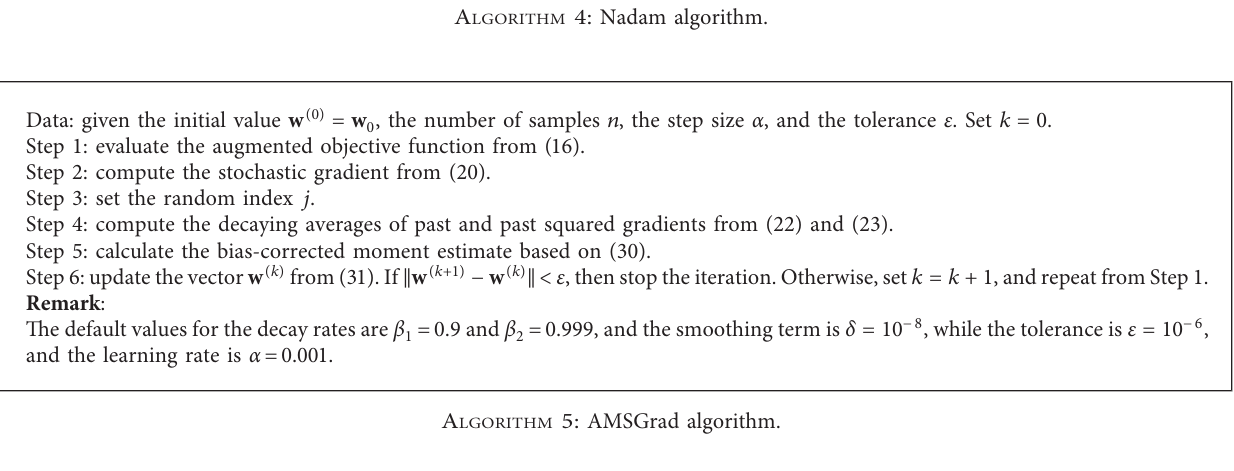
A LGORITHM 4: Nadam algorithm.